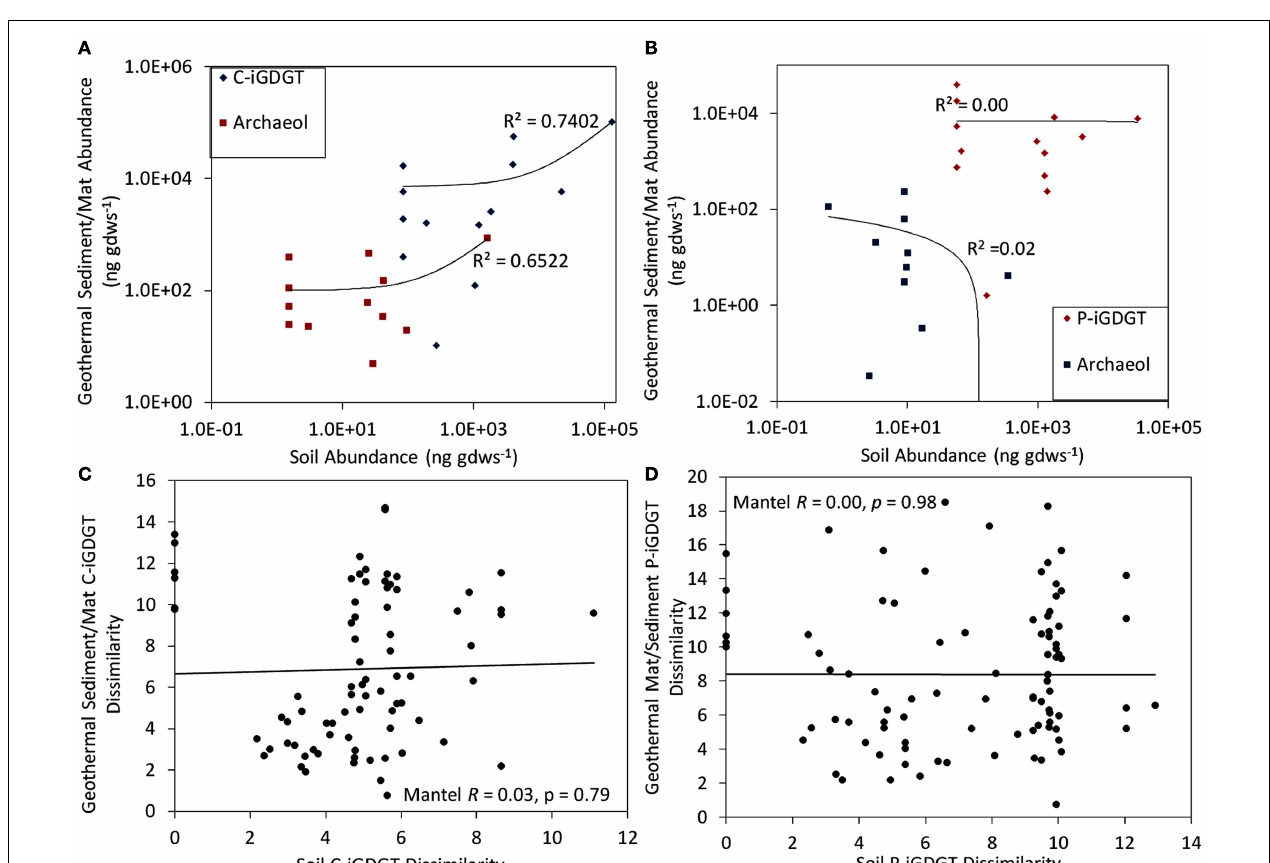
geothermal sediments/mats plotted as a function of the dissimilarity in the composition of C-iGDGTs in surrounding soils (C) . Mantel regression between a matrix describing the dissimilarity in the composition of P-iGDGTs in 26 geothermal sediments/mats plotted as a function of the dissimilarity in the composition of P-iGDGTs in surrounding soils (D) . Data in panel A and B are plotted on a log–log scale with a linear regression depicting the relationship. The data used to construct plots (A–D) is presented in Tables 2 and 3